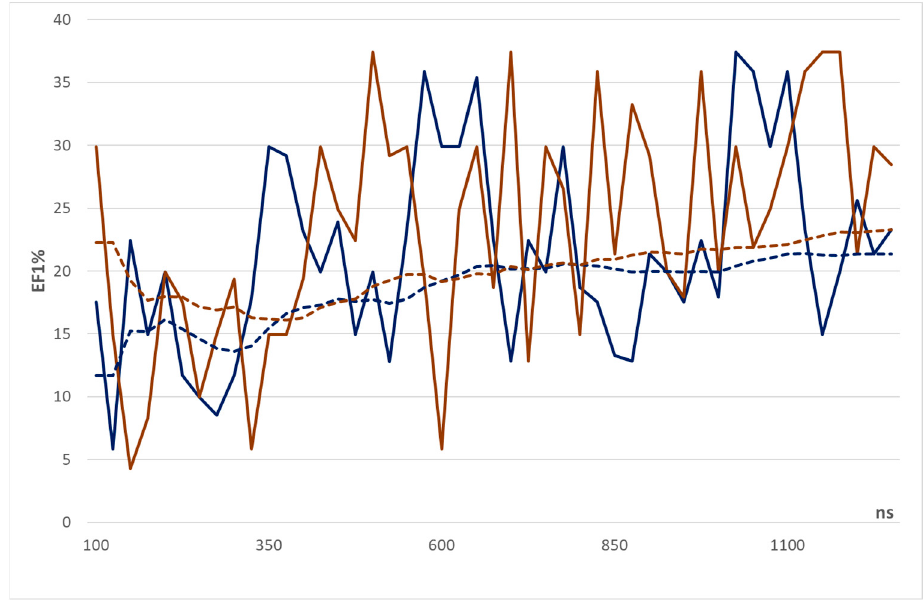
Figure 1. Trends of the EF1% values (bold lines) and the EF1% cumulative means (dashed lines) for non-optimized (blue lines) and optimized (brown lines) frames as extracted from the MD run.